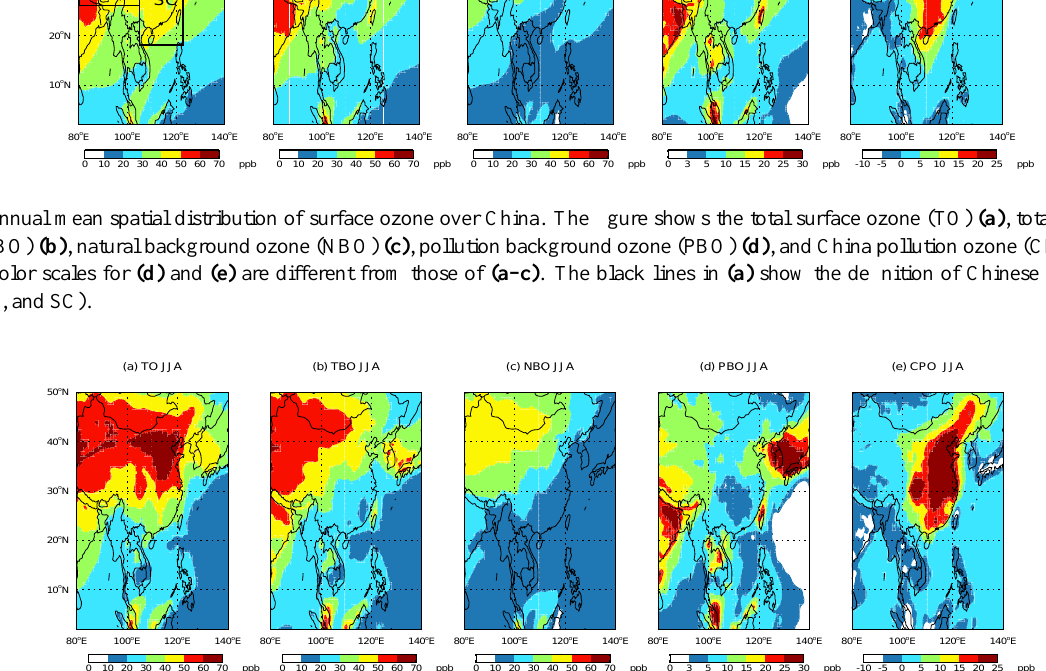
Fig. 6. Same as in Fig. 5, but for summer (June, July and August) mean value.